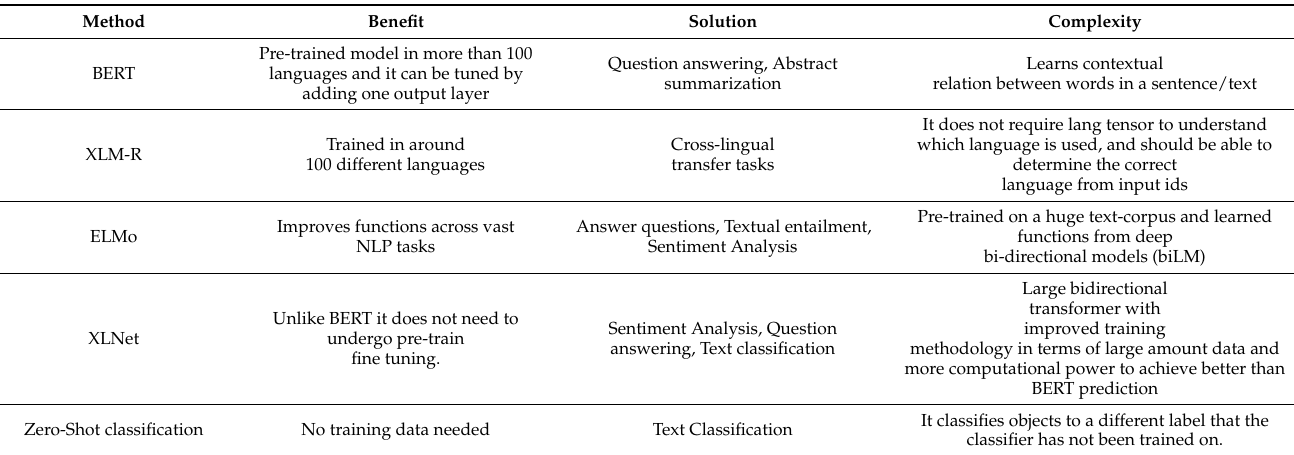
Table 1. Summary of pre-trained NLP